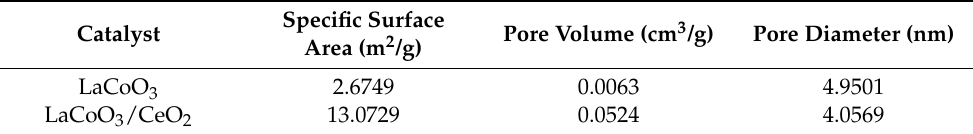
Table 1. BET surface area and pore structure of LaCoO 3 catalysts with different supports.